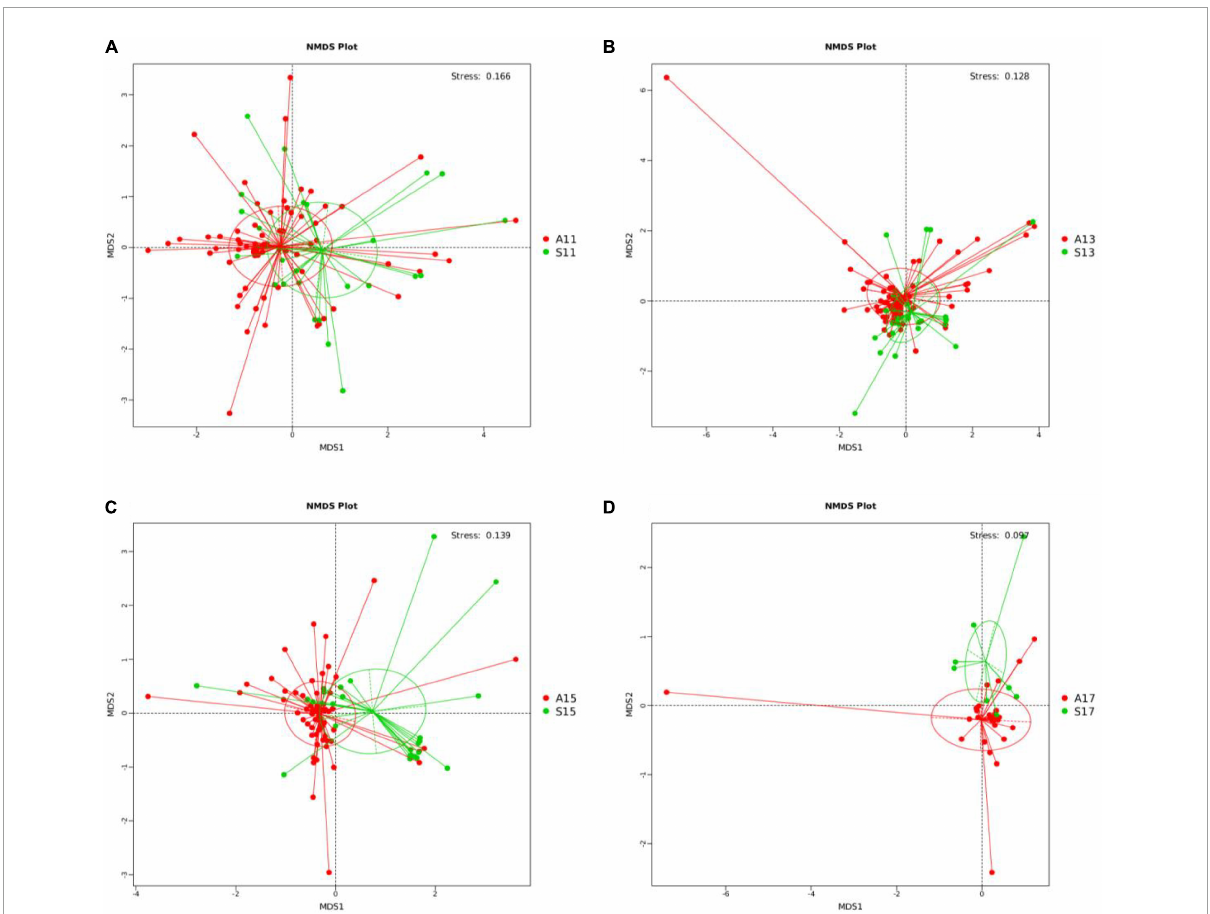
FIGURE1 NMDS analysis between the SGA and AGA groups on days 1, 3, 5, and 7. (A) NMDS analysis on day 1. (B) NMDS analysis on day 3. (C) NMDS analysis on day 5. (D) NMDS analysis on day 7. NMDS, non-metric multi-dimensional scaling. The red points represent belonging to the AGA group, and the green points represent belonging to the SGA group. S11, gut microbiota of the SGA group on day 1; A11, gut microbiota of the AGA group on day 1; S13, gut microbiota of the SGA group on day 3; A13, gut microbiota of the AGA group on day 3; S15, gut microbiota of the SGA group on day 5; A15, gut microbiota of the AGA group on day 5; S17, gut microbiota of the SGA group on day 7; A17, gut microbiota of the AGA group on day